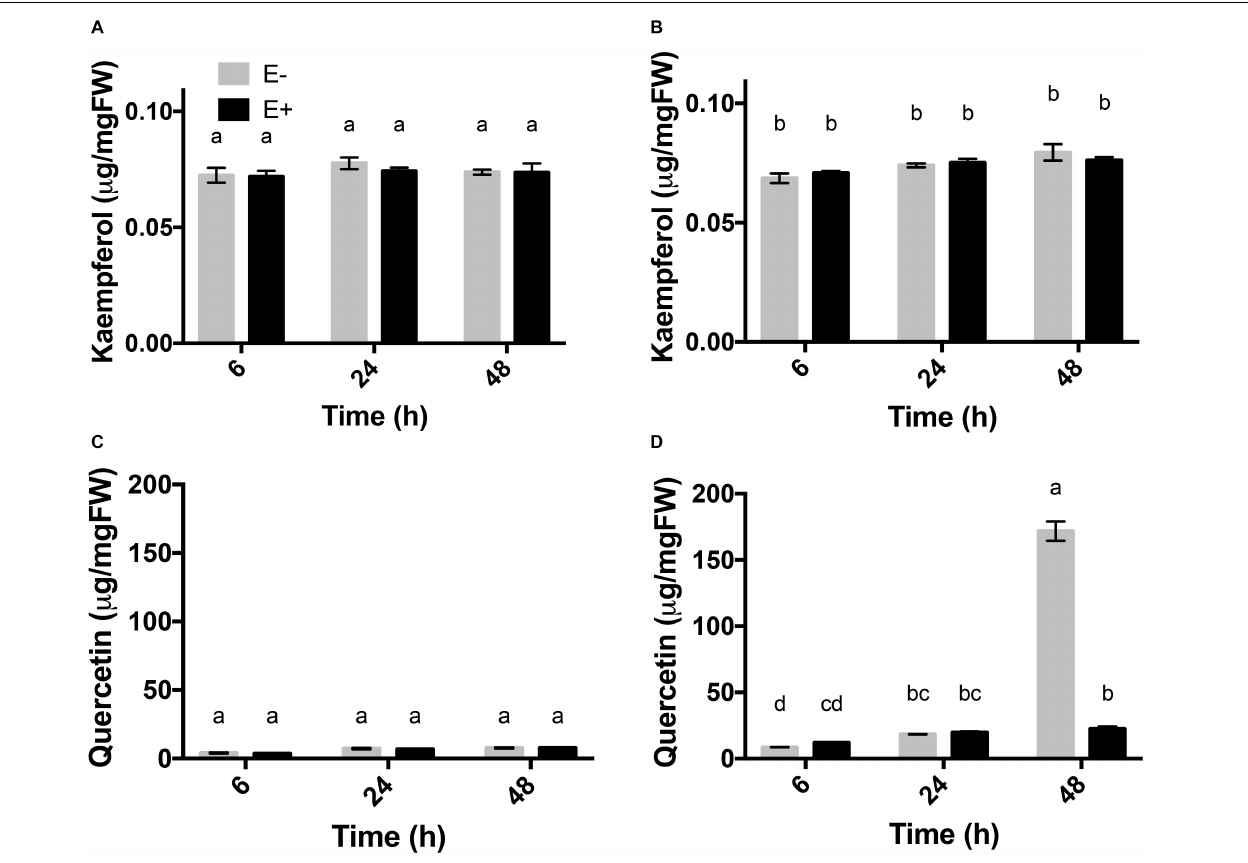
FIGURE 4 | Flavonols accumulation profile in response to UV-B radiation in leaves of C. quitensis . Flavonols content ( µ g/mg fresh weight) of kaempferol (A,B) and quercetin (C,D) in the leaves of C. quitensis obtained at different times of UV-B exposure were analyzed. Plants exposed to control [without radiation UV-B